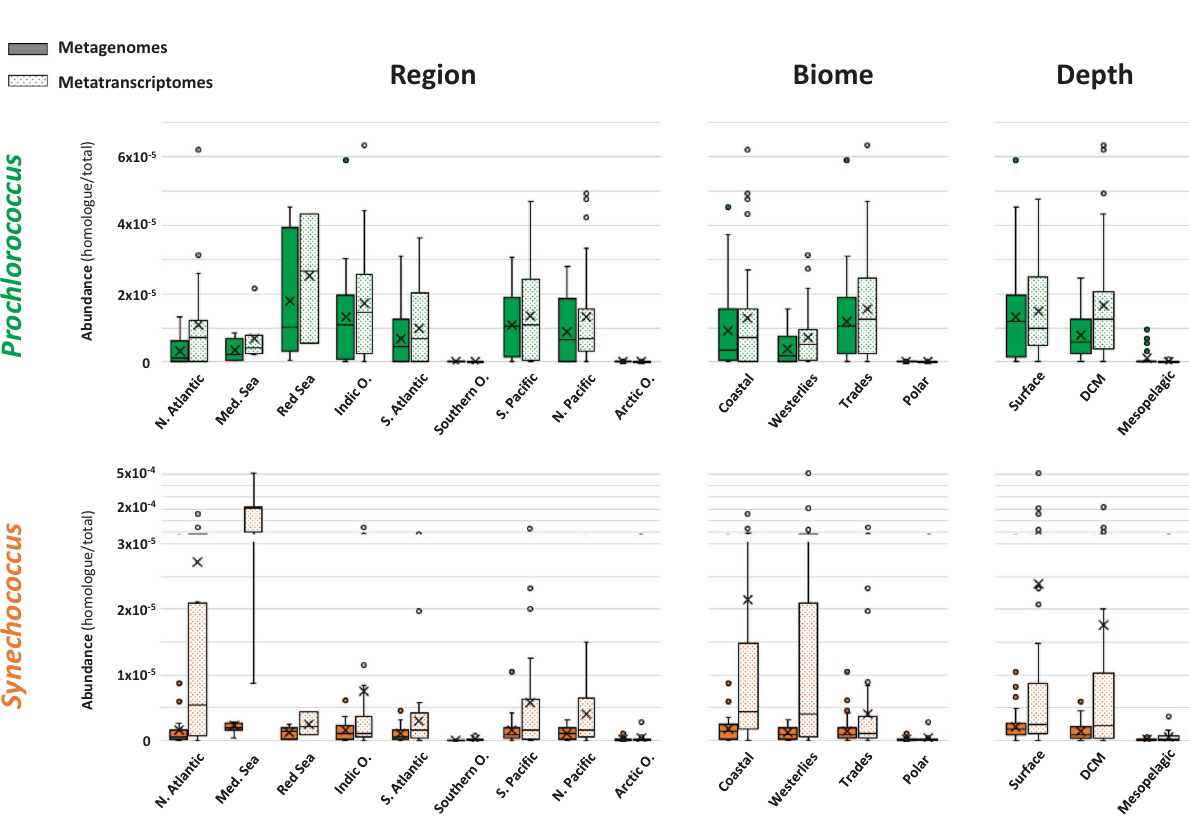
Fig. 3 Distribution of PilA1 amongst marine ecosystems. Whisker box plots showing pilA1 gene abundance in Prochlorococcus (green) and Synechococcus (orange) in metagenomes (solid bars; n mg = 174) and metatranscriptomes (dotted bars; n mt = 178) generated from all fi lters (0.2 – 3 µ m) obtained from 125 sampling stations of the TARA Oceans global marine survey. Abundance was calculated by dividing the sum of the abundances of pilA1 homologs assigned to each genus by the sum of total gene abundance from all reads from the sample. Data are presented by oceanic region (North Atlantic Ocean, n mg = 23, n mt = 21; Mediterranean Sea, n mg = 12, n mt = 7; Red Sea, n mg = 6, n mt = 3; Indic Ocean, n mg = 27, n mt = 22; South Atlantic Ocean, n mg = 19, n mt